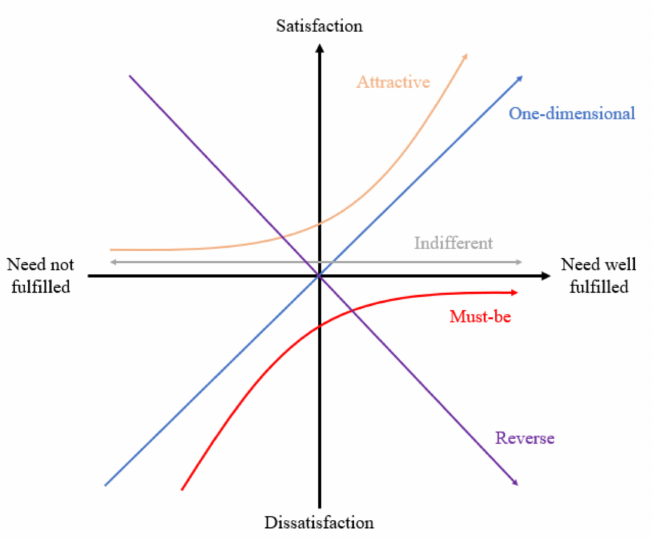
Figure 2. Kano model